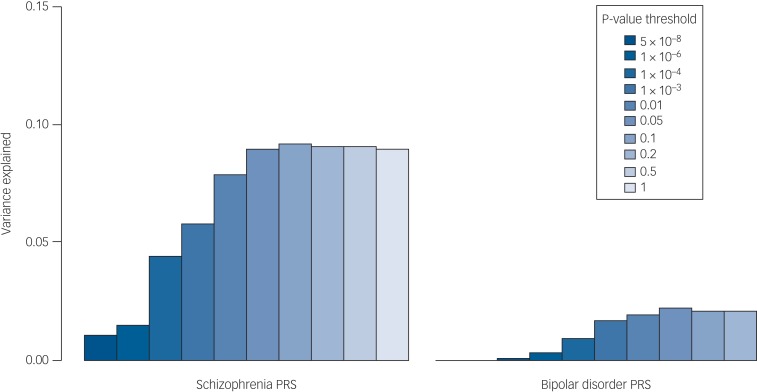
Percentage of the variance in disease risk explained by the schizophrenia and the bipolar disorder polygenic risk scores (PRSs). The proportion of variance explained (calculated as Nagelkerke's pseudo-R2) was computed by comparison of the full model (either schizophrenia-based or bipolar disorder-based PRS plus covariates) to the reduced model (covariates only). As per standard procedures,4 (ten different P-value thresholds (PT) were used to select risk alleles used in the computation of PRSs. The variance explained at each P-value threshold (5 × 10−08, 1 × 10−06, 1 × 10−04, 1 × 10−03, 0.01, 0.05, 0.1, 0.2, 0.5 and 1) is shown. Significance testing results are available in Supplementary Table S6.